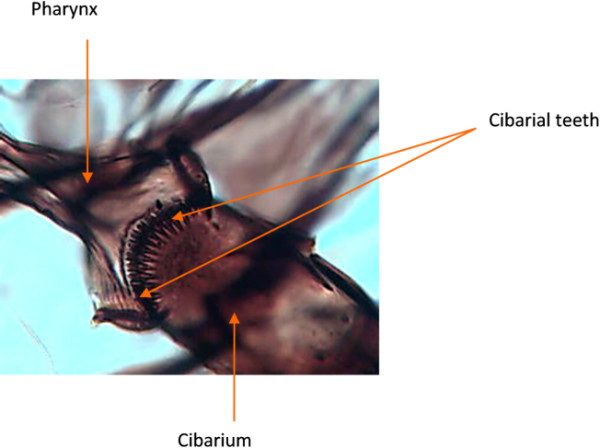
Cibarial armature of Anopheles gambiae s.l.